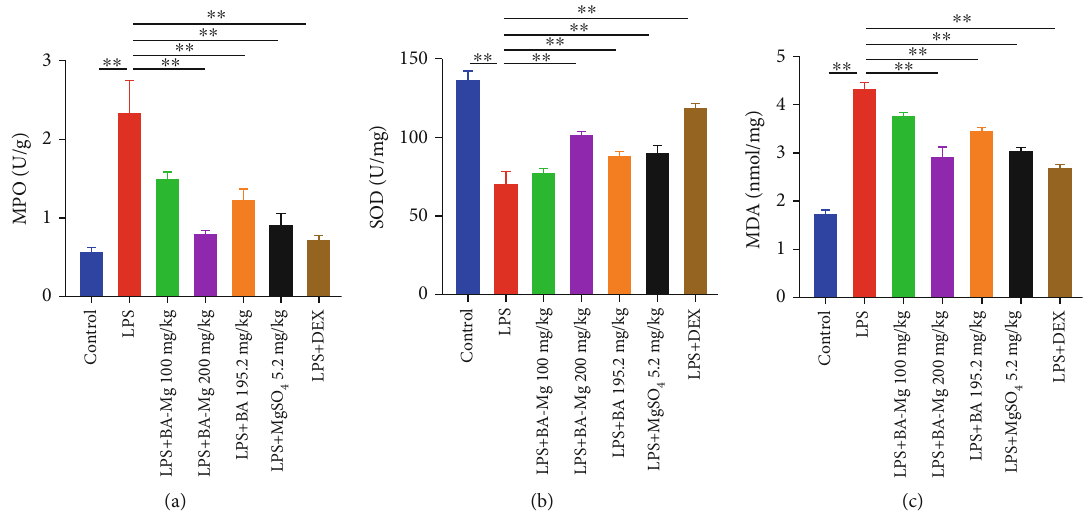
Figure 4: E ff ect of BA-Mg on the MPO (a), MDA (b), and SOD (c) levels in lung tissue of mice injured by LPS. Data were represented as mean ± SD ( n = 5 ). ∗ P < 0 : 05 , ∗∗ P < 0 : 01 versus LPS group.